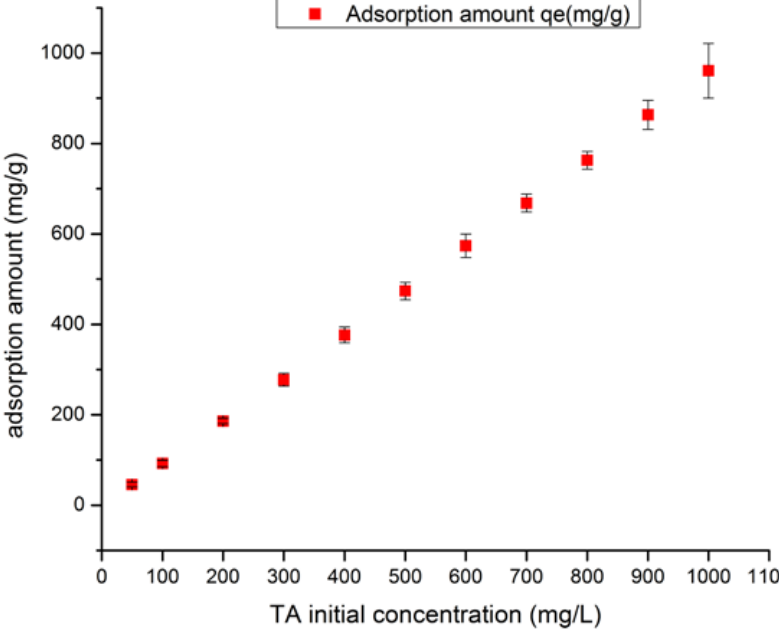
Figure 10. Adsorption isotherm of TA on SS as function of initial concentrations. Adsorption conditions: pH = 6.6; T = 293 K; time = 225 min; SS dosage= 100 mg, volume = 100 mL.